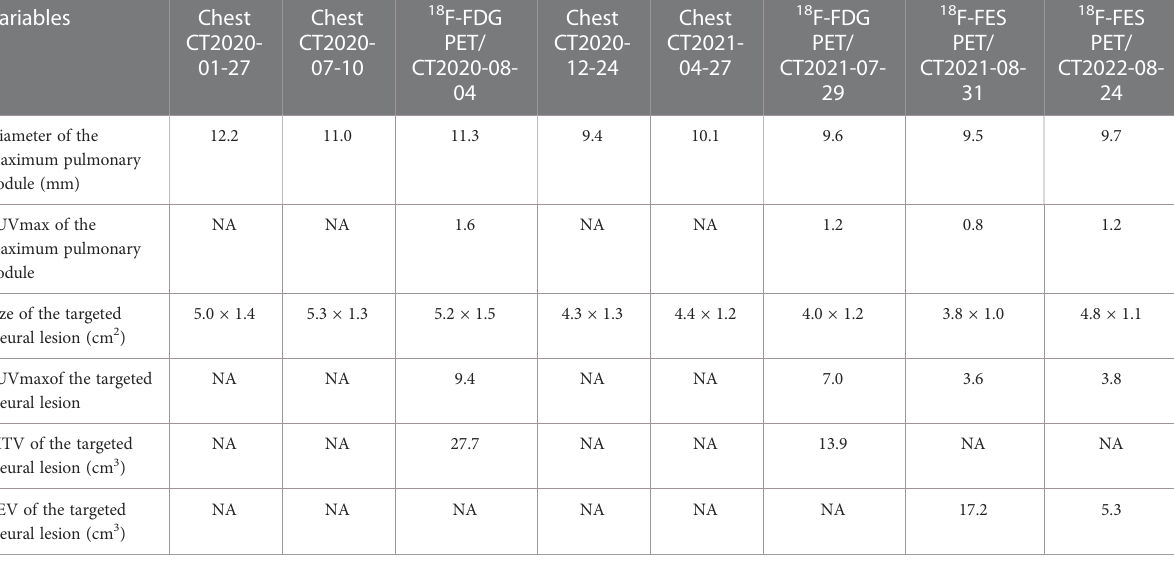
TABLE 1 Imaging evaluation of the patient.